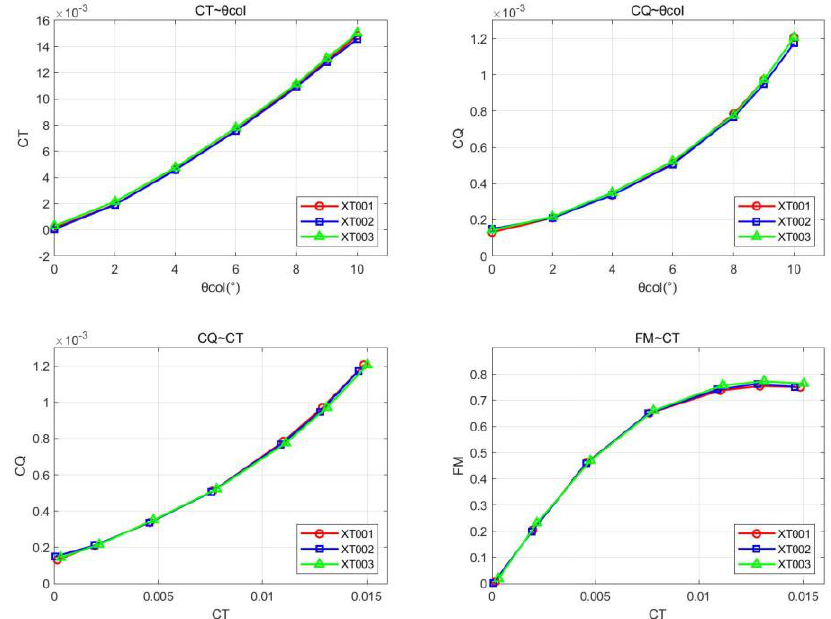
Figure 8. The repeatability curves of aerodynamic coefficients and hover efficiency of hover test.